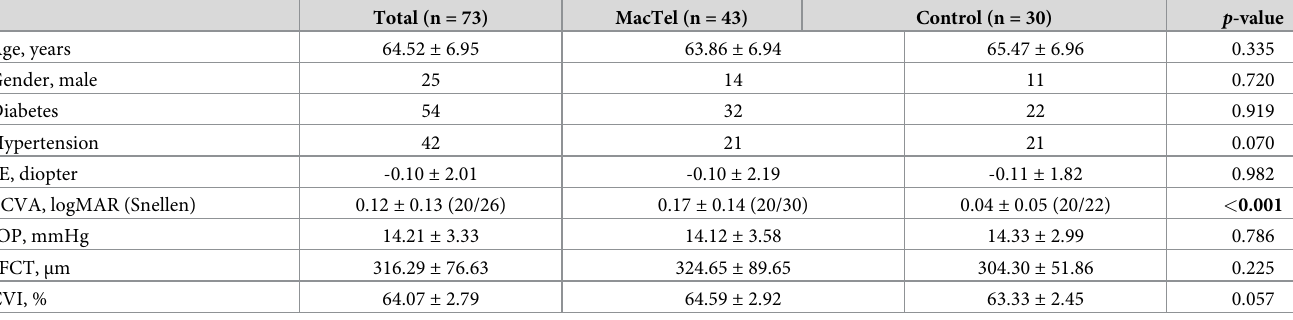
Table 1. Demographic and clinical characteristics of the study participants at